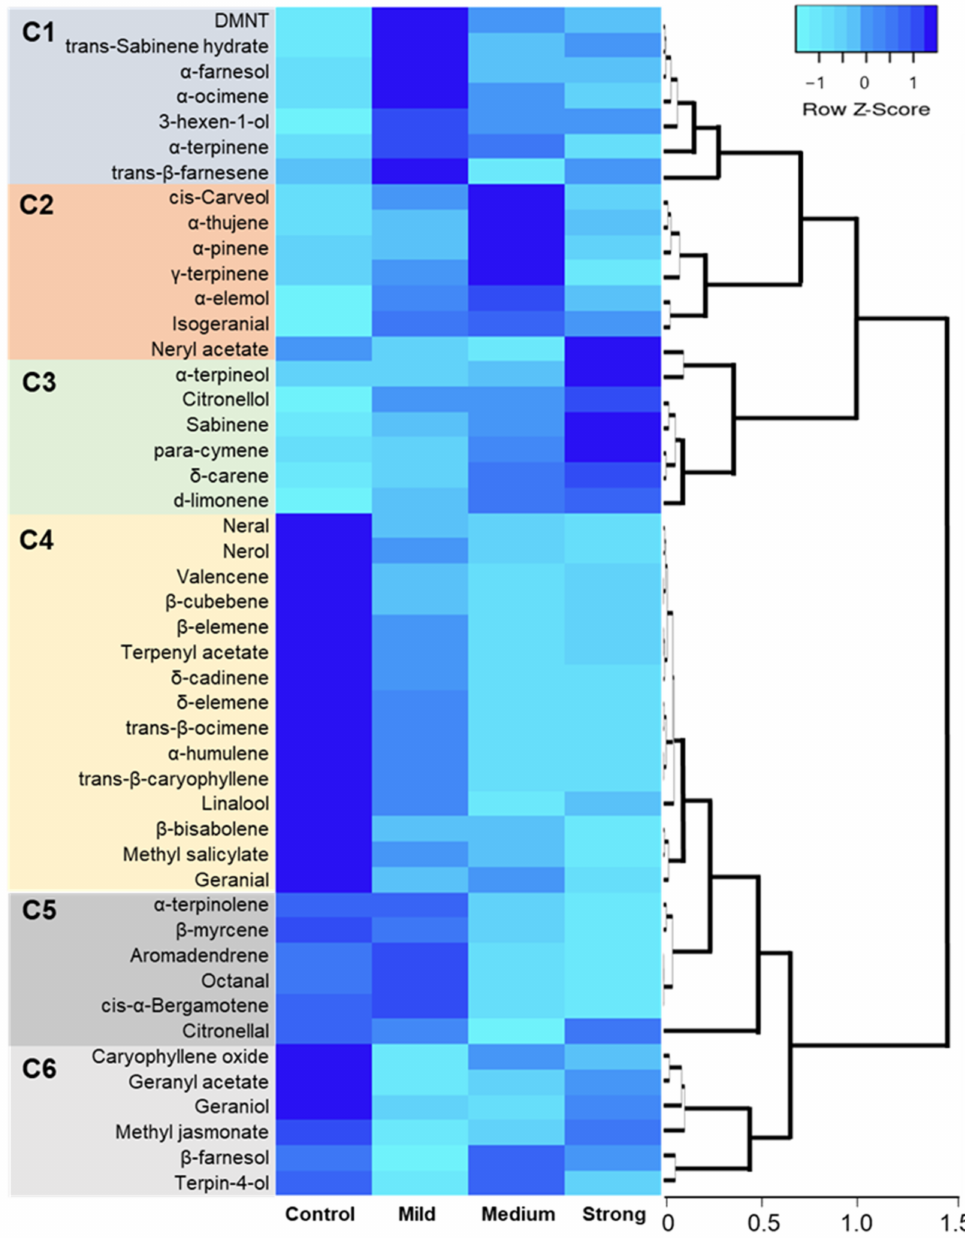
Figure 4. Two-way hierarchical cluster analysis and heat map of the VOCs released leaves from C. macrophylla with different degrees of photobleaching. Clusters 1–6 represent groups of compounds with a similar response to the reduction of carotenoids. Rows represent compounds, while columns represent treatments (photobleaching degrees). Cells are the mean peak area of each compound ( n ranges from 6 to